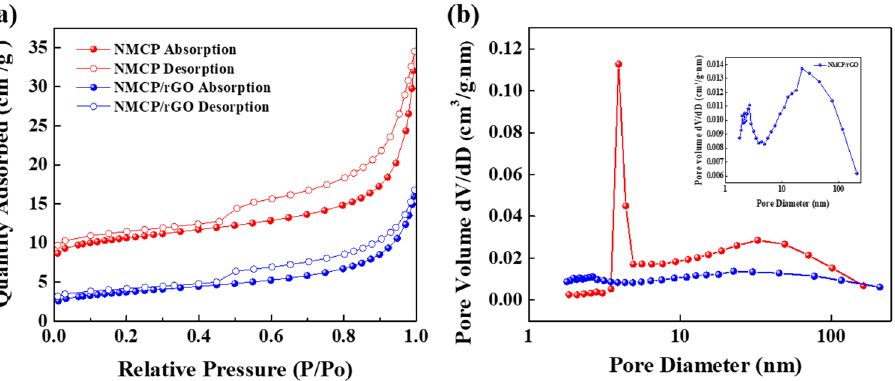
Figure 6. Bare NMCP and NMCP/rGO: ( a ) absorption and desorption isotherms; ( b ) pore size distributions. Inset in ( b ) shows the pore size distribution of NMCP/rGO in large magnitude.